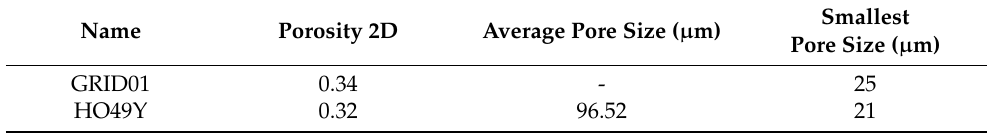
Table 1. Values of porosity, average pore size and smallest pore size of the